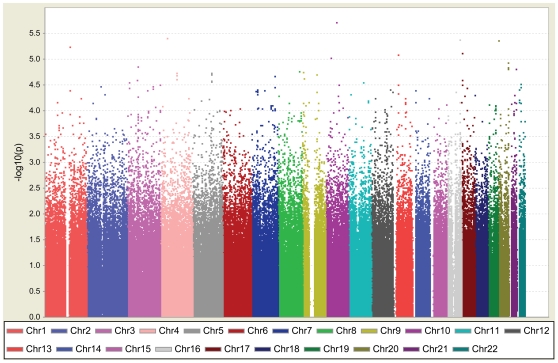
Graphical summary of T2D GWAS in a Han Chinese population.T2D association was determined for SNPs on the Illumina HumanHap550K-Duo chip. The y-axis represents the −log10
P value and the x-axis represents each of the 516,212 SNPs used in the primary scan of 995 T2D cases and 894 controls.